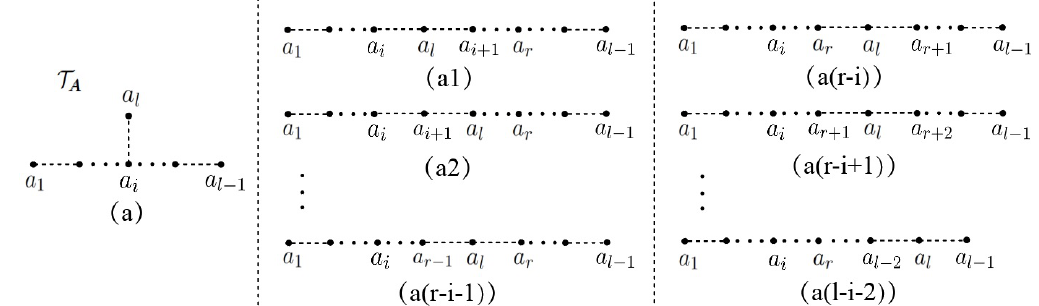
Figure 7 . The graph (a) is a typical graph where a node a l is planted on a i ( i < r ) of a simple chain. The corresponding simple chains for (a) are given by (a1), . . . , (a(r-i-1)) (where a between a and a ) and (a(r-i)). . . (a(l-i-2)) (where a i r